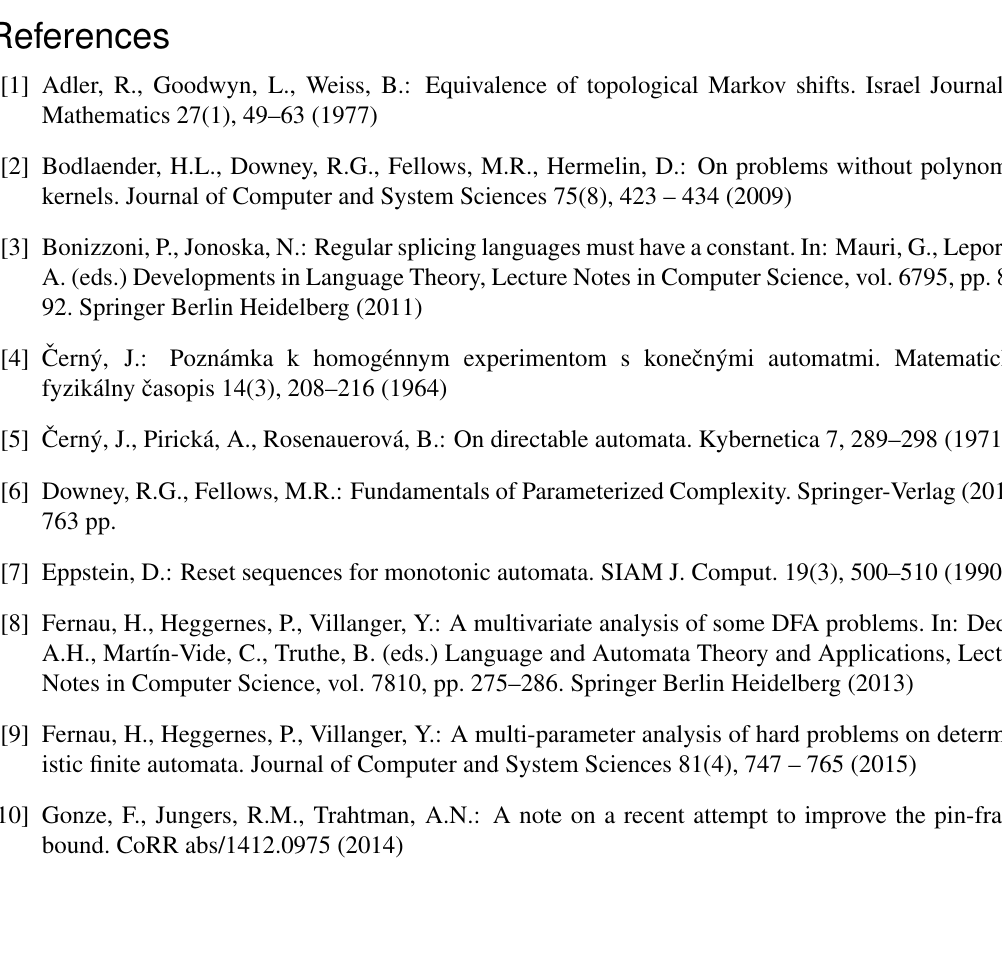
Tab. 3: Complexity of SRCW restricted to fixed | I | , fixed singleton W , and with possible assumption of strong connectivity (S.C.). The results come from [13] and